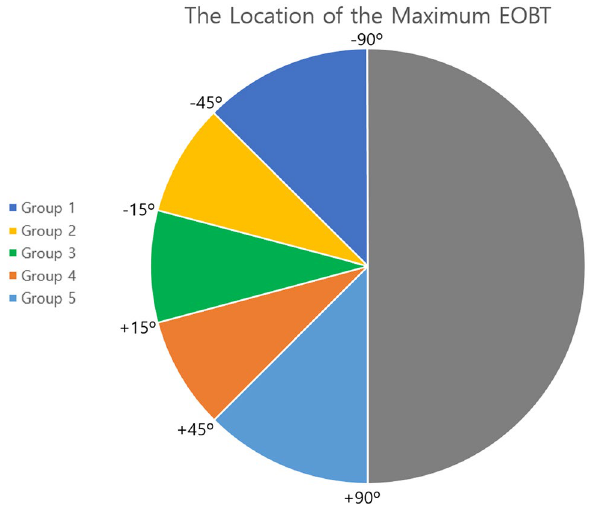
Figure 4. Classification for subgroup analysis according to the angular location of the longest externally oblique border tissue (EOBT). Since this figure shows the angular location with respect to the right eye, in the case of the left eye, the angular location was indicated by flipping it horizontally. Group 1: < – 45°, Group 2: – 45° ~ – 15°, Group 3: – 15° ~ + 15°, Group 4: + 15° ~ + 45°, Group 5: > +